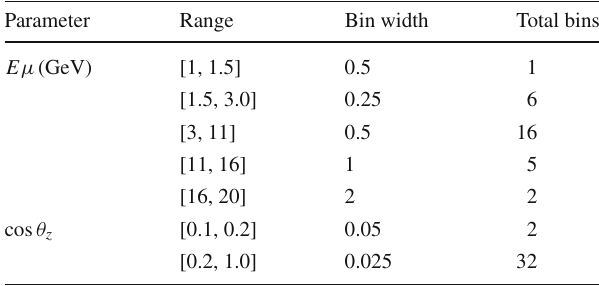
Table 3 The binning scheme adopted for the reconstructed parame- ters E μ , cos θ z and E h for muons and hadrons, respectively, where χ 2 is estimated considering combined muon and hadron information of down-going neutrino induced